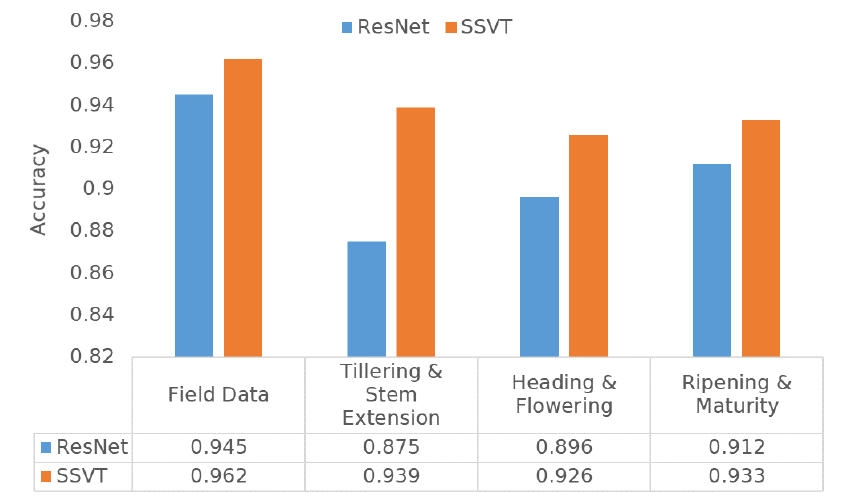
Figure 8. The model performance on independent drone datasets captured throughout all grow- ing stages.